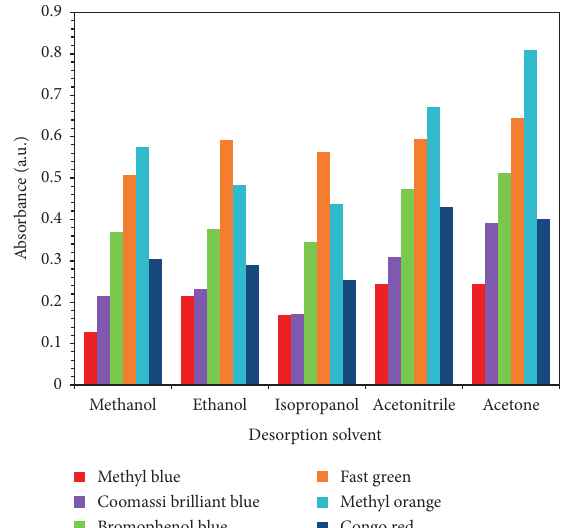
Figure 10: Effect of desorption solvent selection on the desorption of the dyes from the CuBTC-monopol monolithic disk inside the polycarbonate microchip. Conditions: sample volume, 300 μ L; sample flow rate, 10 μ L · min − 1 ; dye concentration, 60 mg · L − 1 ; desorption solvent volume, 150 μ L; flow rate, 10 μ L · min − 1